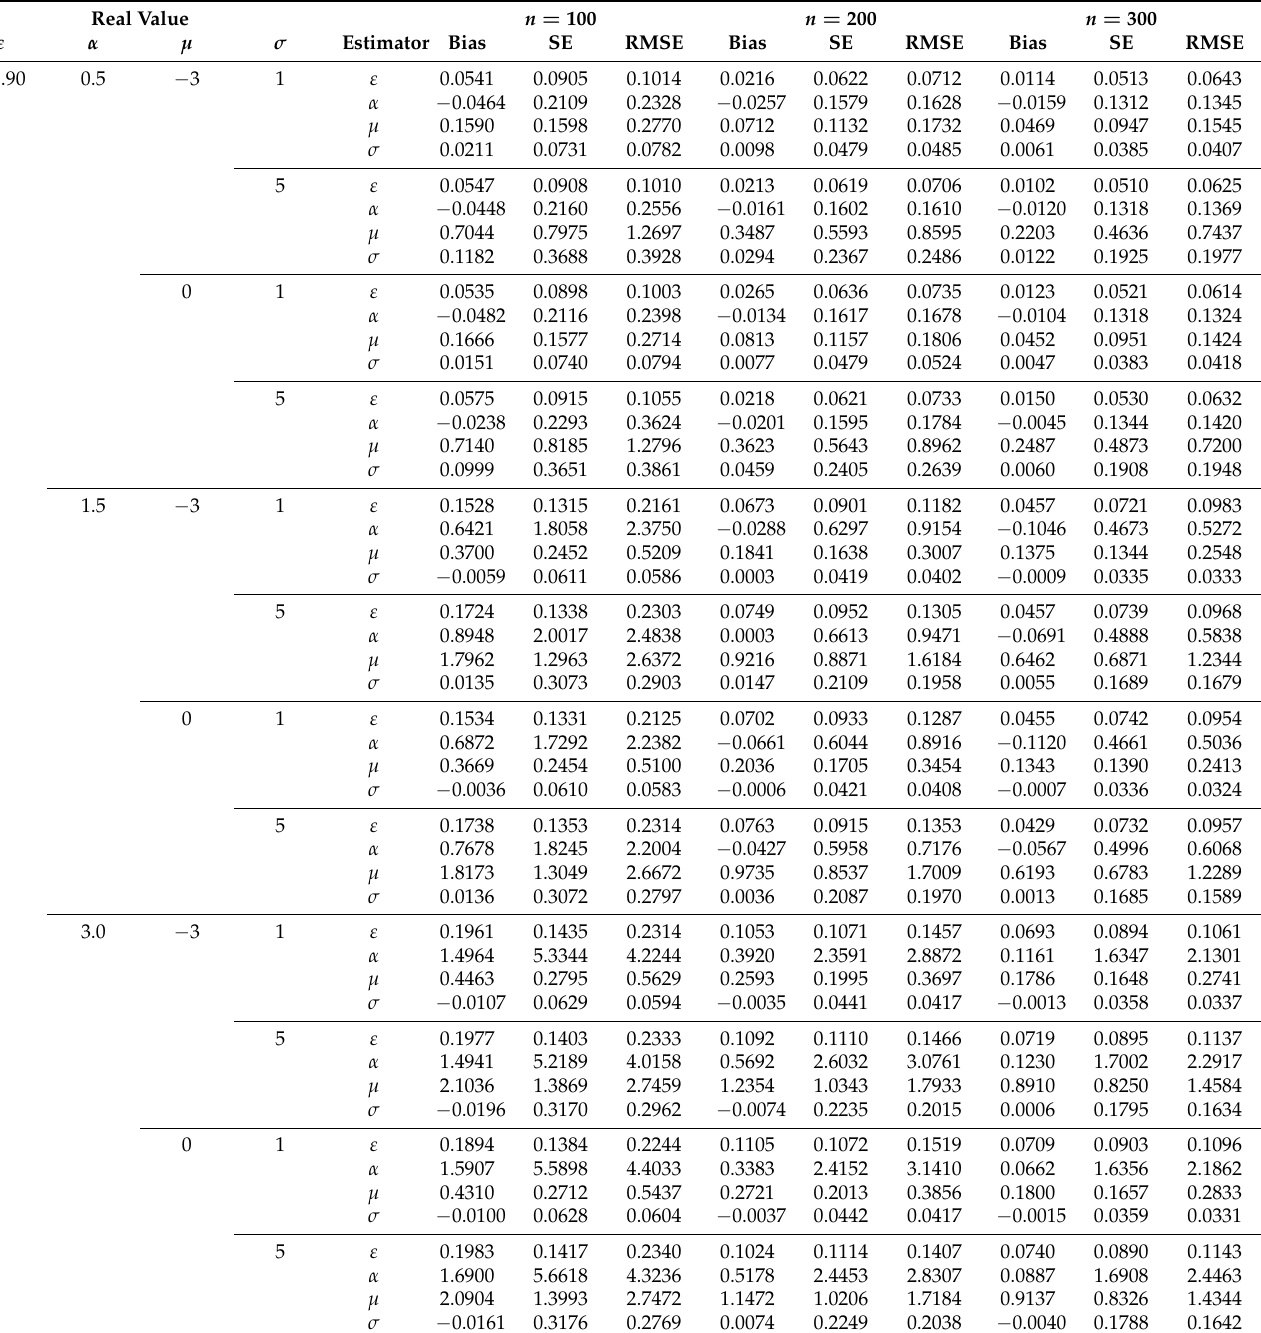
Table 1. Recovery parameters for the ML estimators in the BESN model: case ε = −